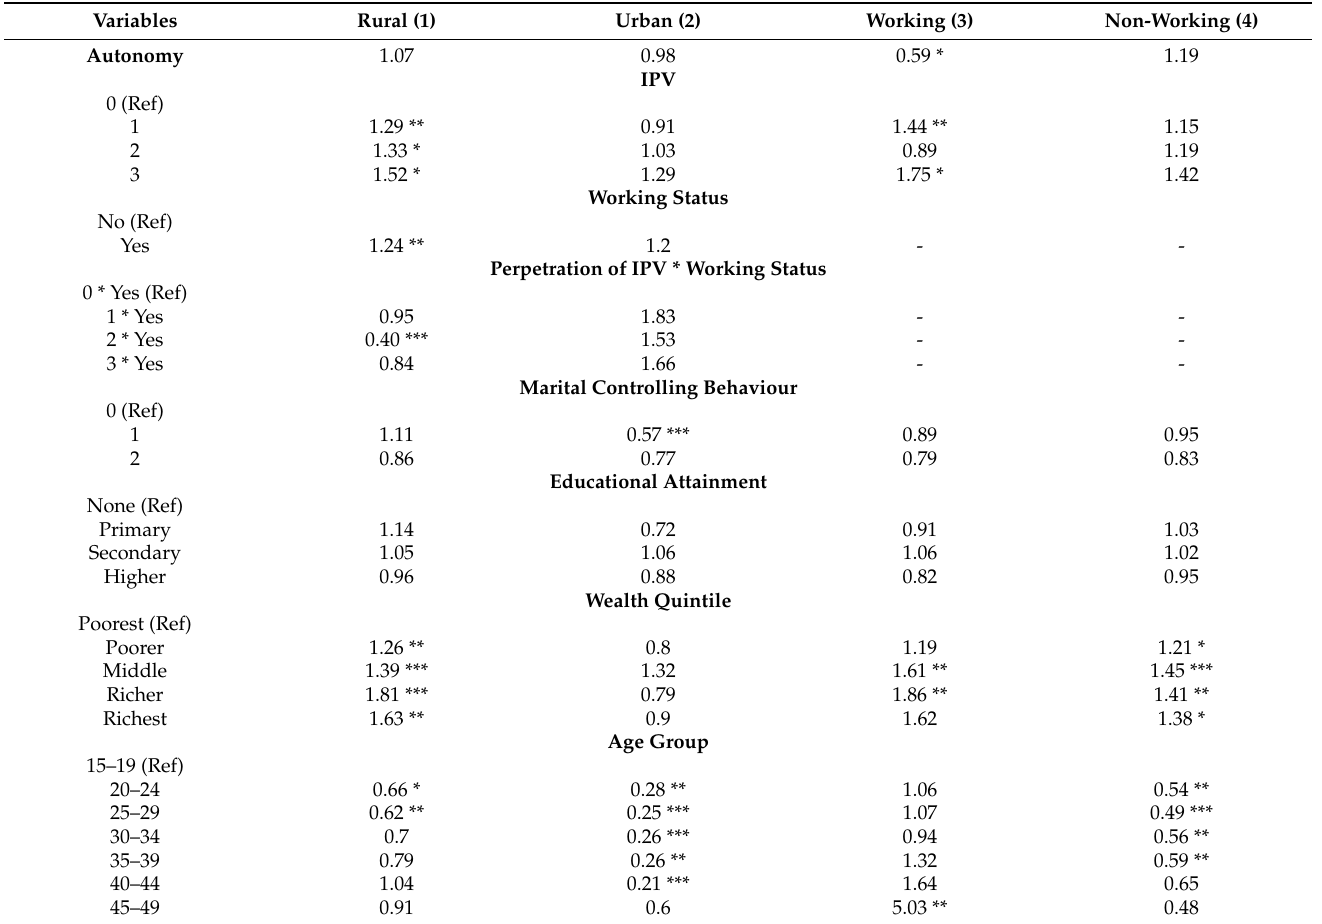
Table 4. Subsample estimation results for adverse birth outcomes, based on residential area and women’s working status #